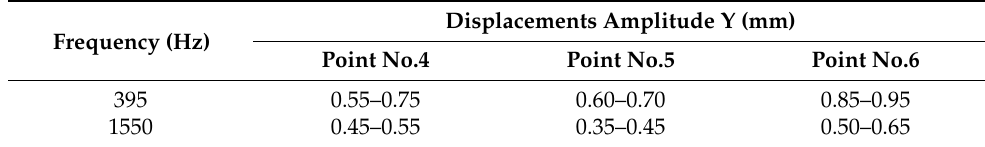
Table 3. Measured displacements amplitude at points 4, 5, and